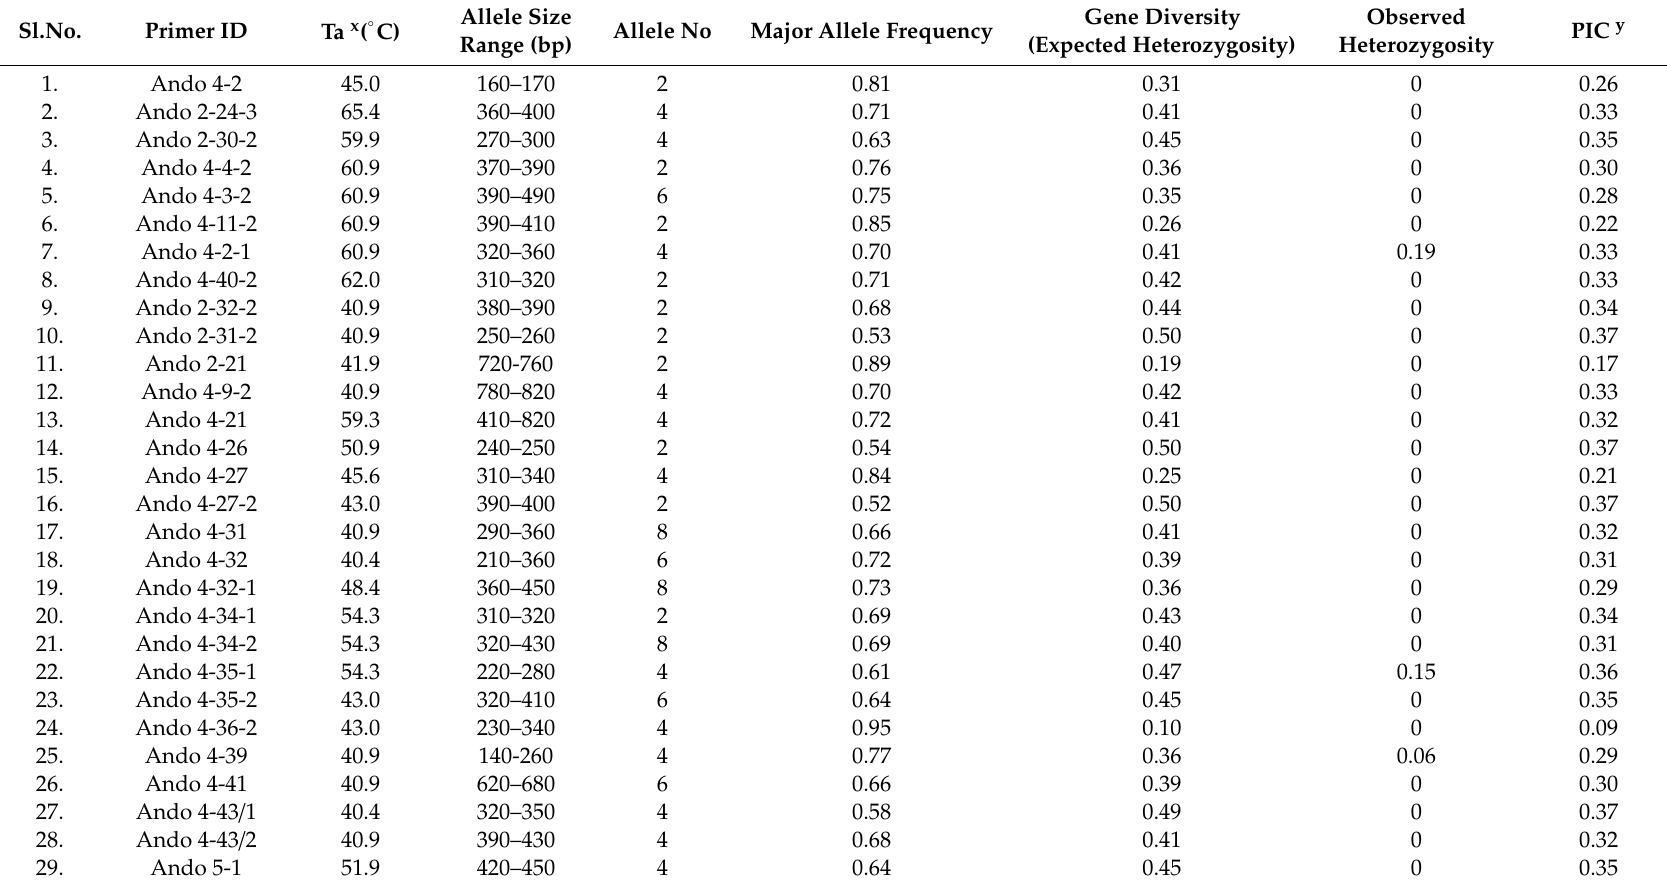
Table 3. Details of allele number, major allele frequency, gene diversity, heterozygosity, and PIC values of developed g-SSRs.